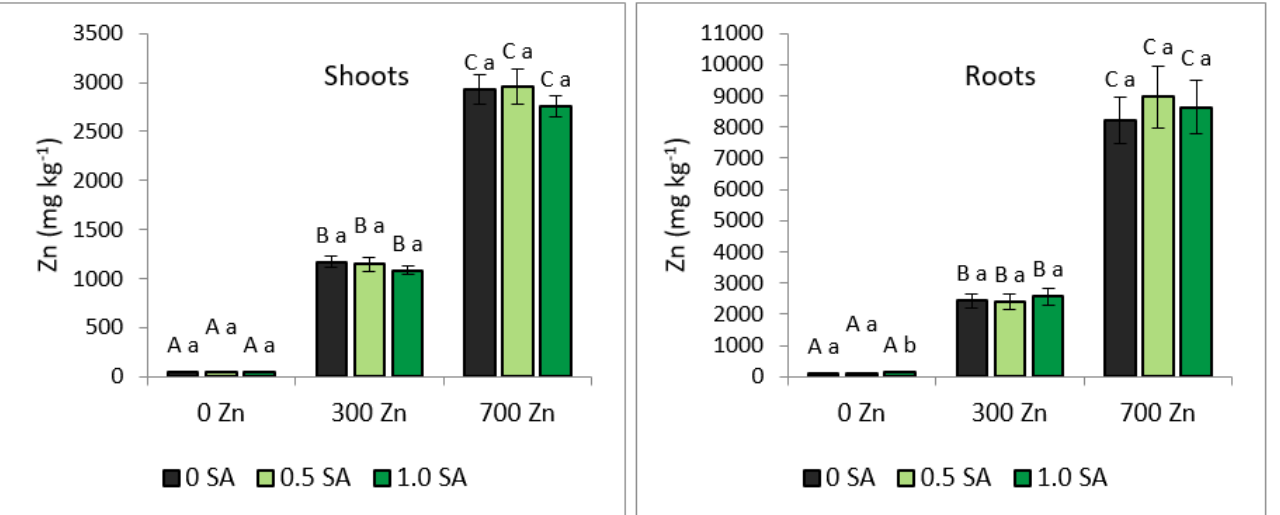
Figure 2. Zn concentration in shoots and roots in Zura cultivar–mean over 2 years. Means marked with different capital letters differ significantly between the Zn levels within each level of SA, and means marked with different small letters differ significantly between the SA levels within each level of Zn (according to Tukey’s HSD test at p < 0.05). Vertical bars represent standard errors (n = 4).